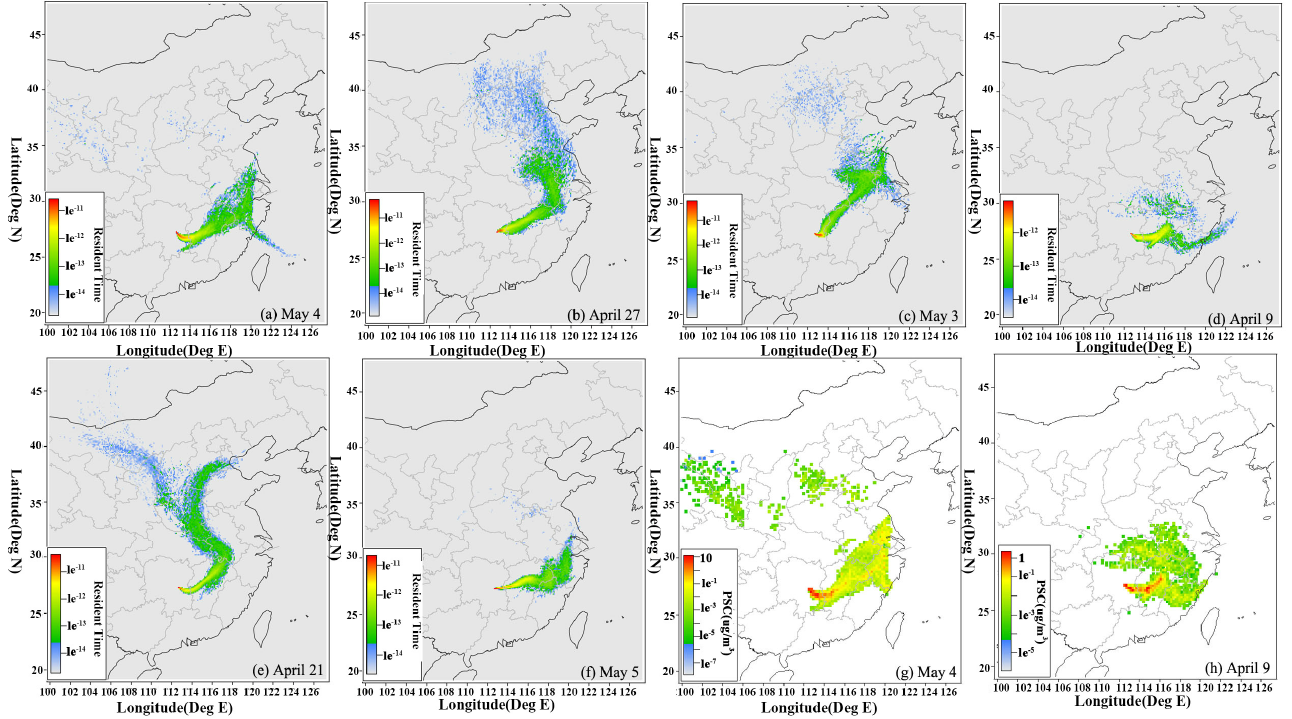
Figure 7. Illustrations of three-day backward retroplumes and the potential source contributions (PSCs) of higher PAH levels. ( a – f ) Map of the “footprint” ( i.e. , 100 m) retroplume (residence time) and ( g – h ) maps of the PSCs of PM 2.5 (PAHs) at Mount